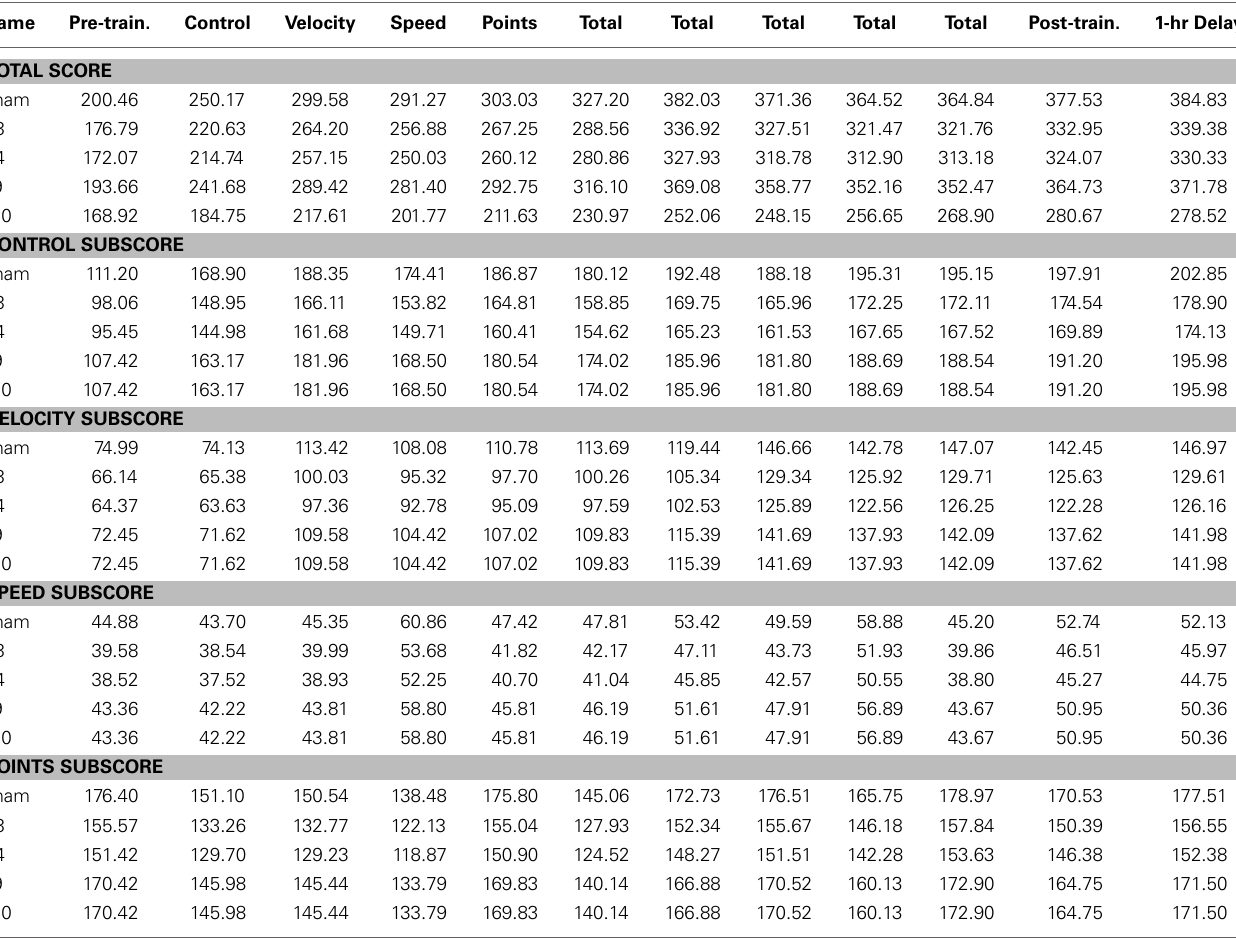
Table 2 | Standard errors for total score and subscores for each training game: pre-training total emphasis (pre-train.), control emphasis, velocity emphasis, speed emphasis, points emphasis, total emphasis, post-training total emphasis (post-train.) and 1-hr delay total emphasis